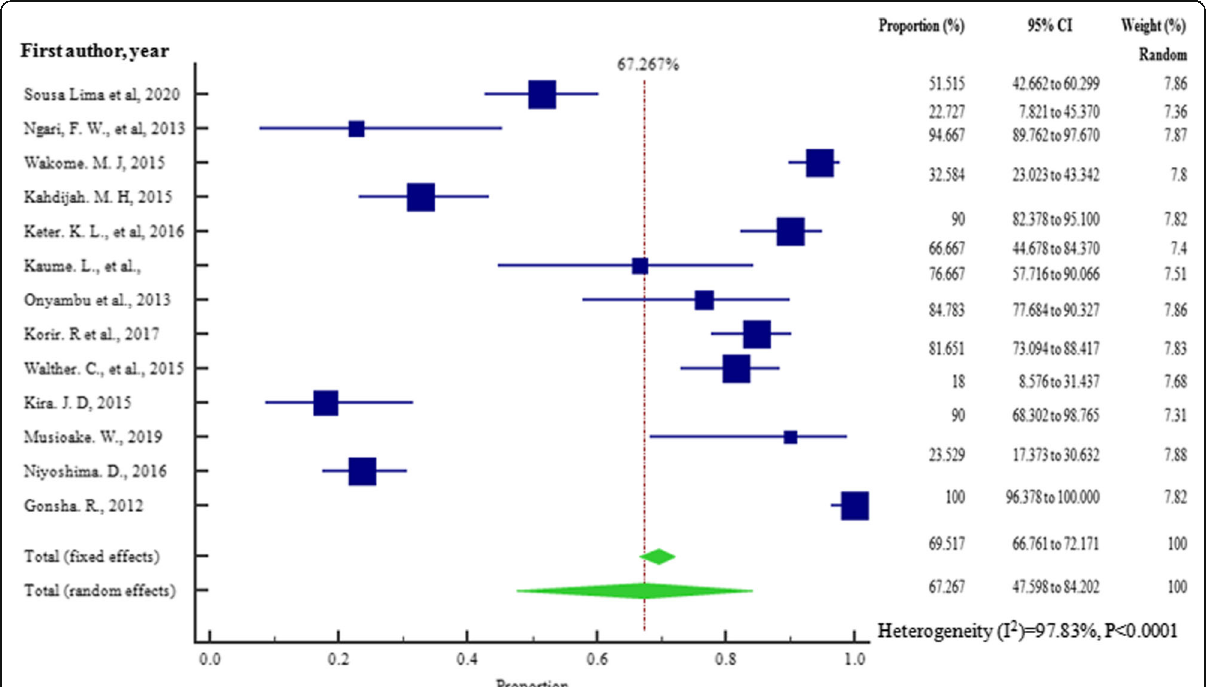
Fig. 12 Forest plot showing sensitivity analysis of the pooled prevalence of bacterial contamination in herbal medicines sold in Tanzania from the year 2000 to